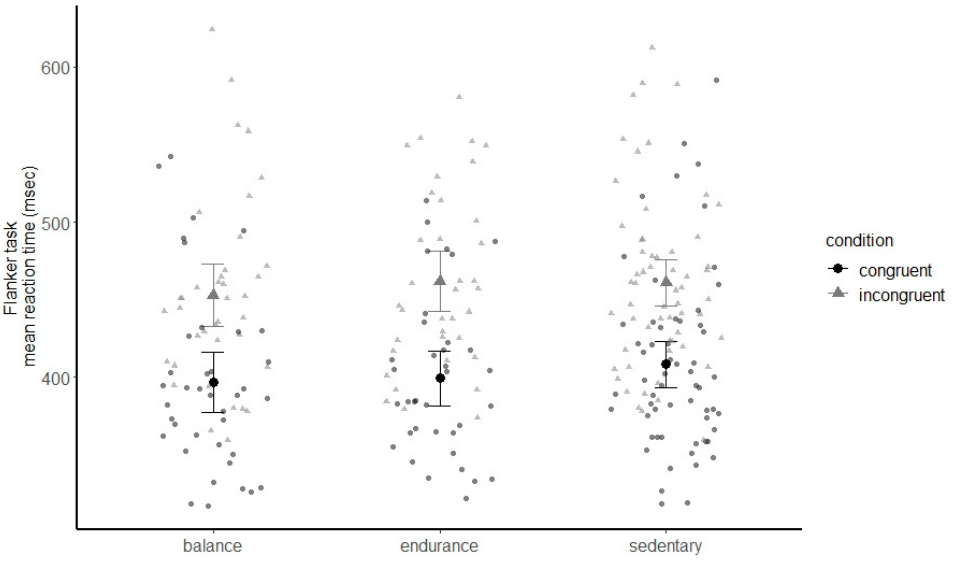
Figure 3. Mean reaction times in the flanker task, separately for congruent versus incongruent trials and for the balance experts, endurance athletes and sedentary participants. Error bars indicate 95% confidence intervals. Data of single participants are plotted in grey.